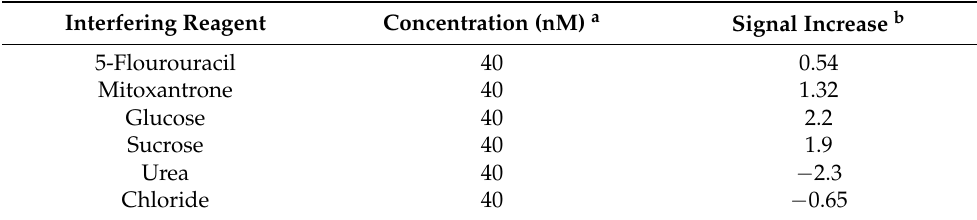
Table 1. Selectivity results of sample 2 for MTX under the environment of common interfering